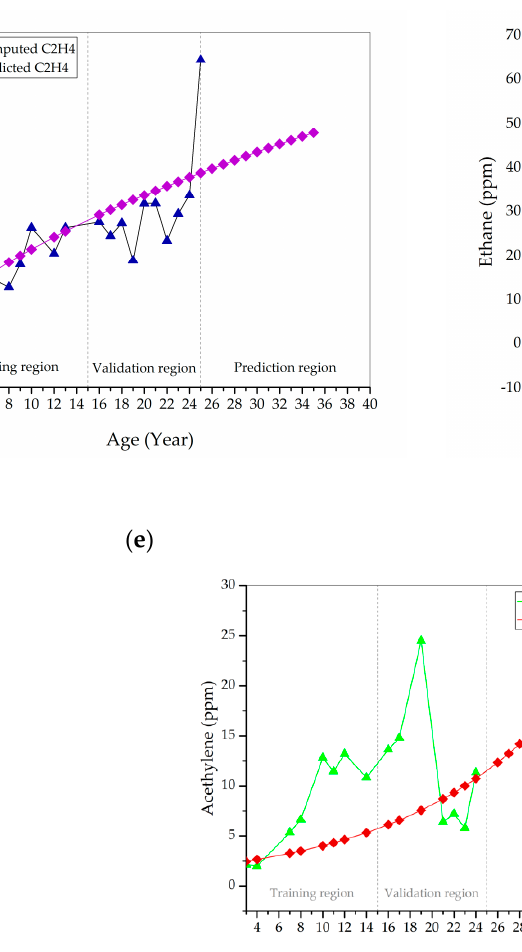
Figure 9. The absolute error percentage between the computed and predicted health index.